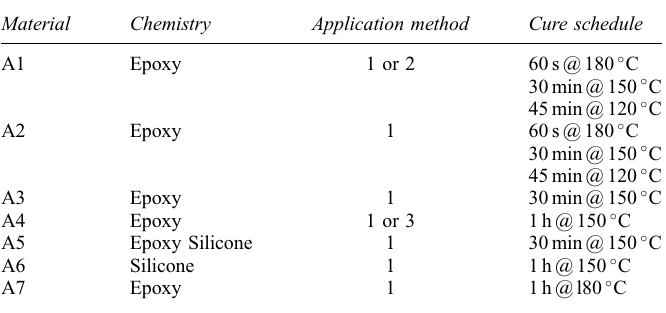
TABLE I Studied Conductive Silver Adhesives (Application Methods: 1 ¼ Dispensing, 2 ¼ Printing, 3 ¼ Pin Transfer).